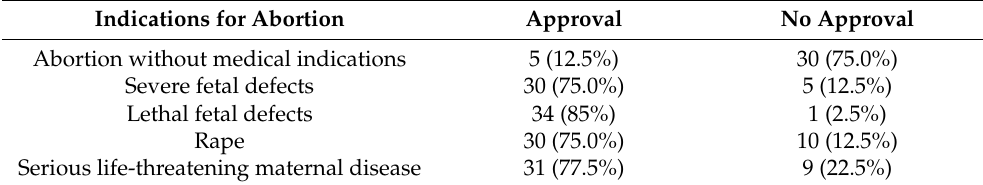
Table 5. Readiness to perform a pregnancy termination personally depending on